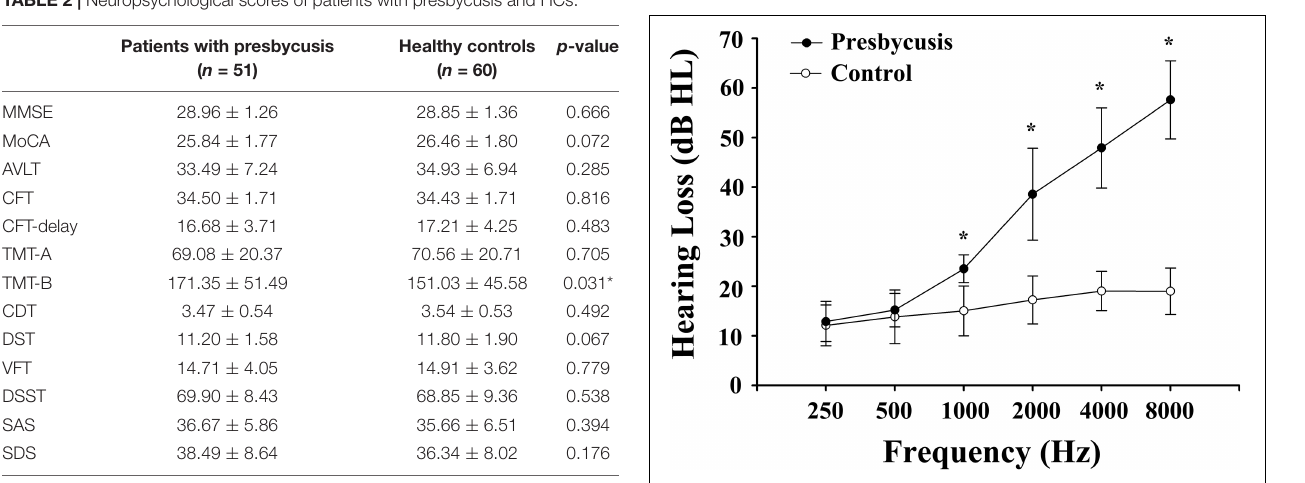
Healthy controls ( n = 60)